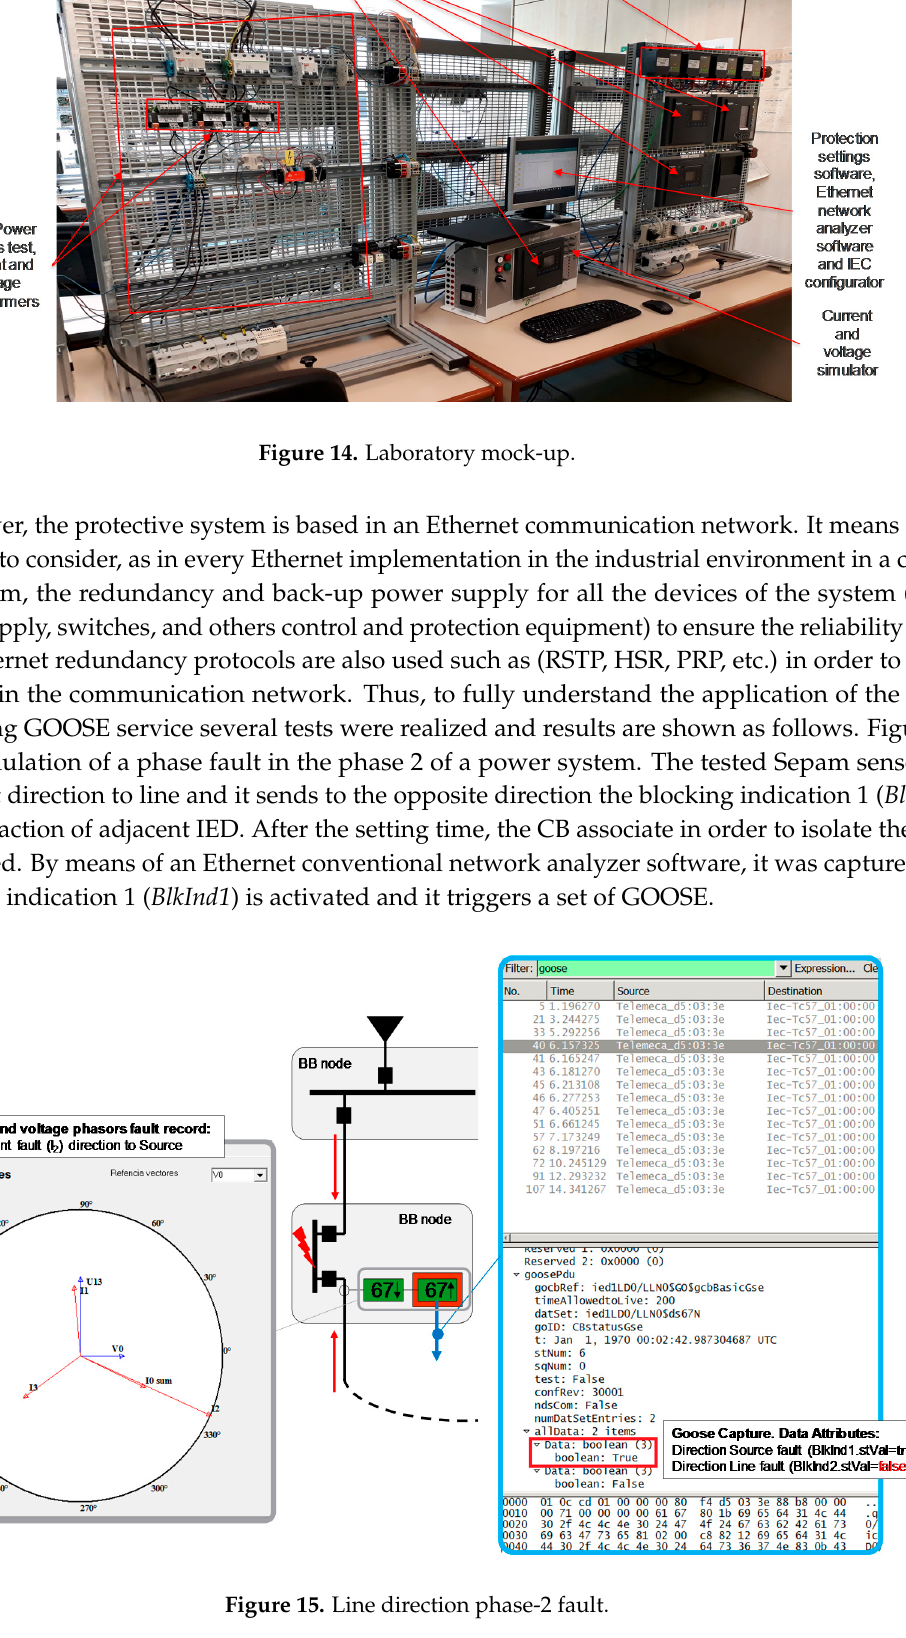
Figure 16. Source direction phase-2 fault. Also, after the setting time, Sepam opened the CB fault. This time, the Ethernet network analyzer capture shows that it is activated the blocking indication 2 ( BlkInd2 ) and it triggers another set of GOOSEs, while the blocking indication 1 keeps false. In addition, it was checked that both block indications return to the inactive state after blocking time of its activation. It allows that in case the CB down is not operating, the next one is ready to trip